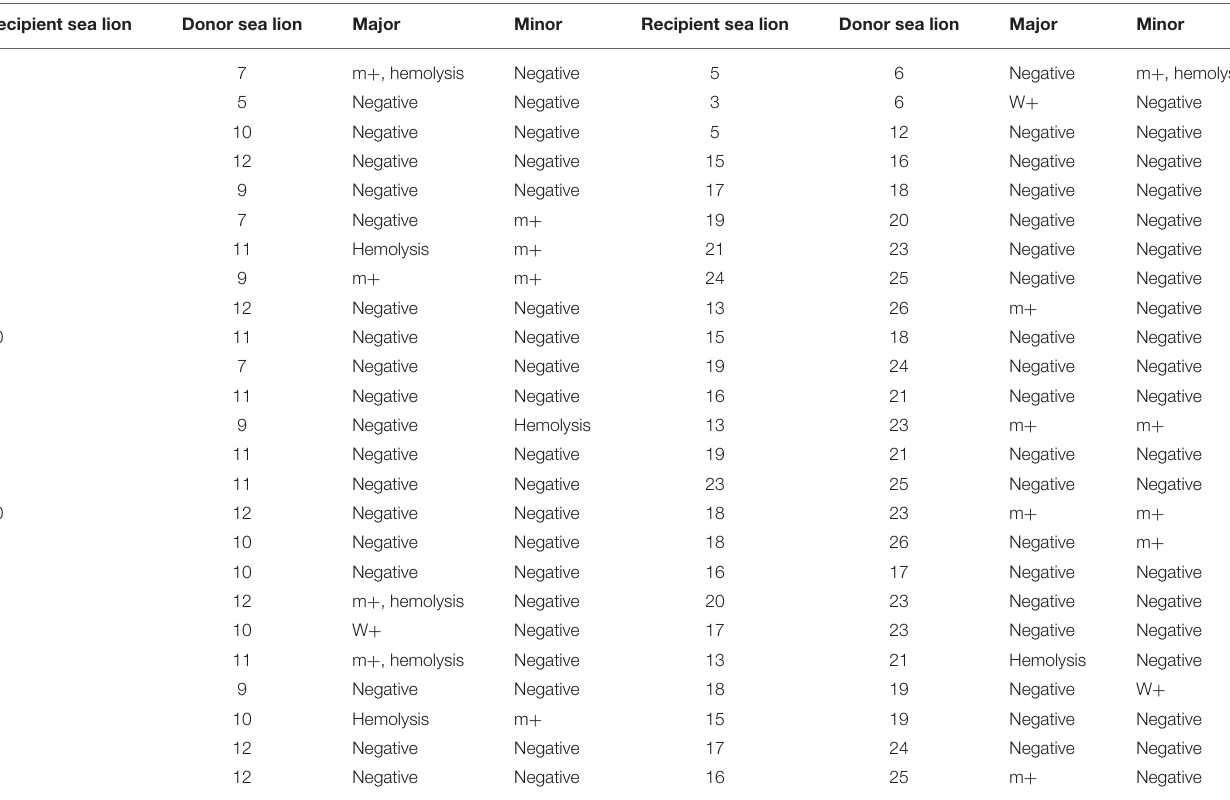
3 12 Negative Negative 16 25 m + Negative Components were reversed for the minor crossmatch. W + and m + are defined in Table 1